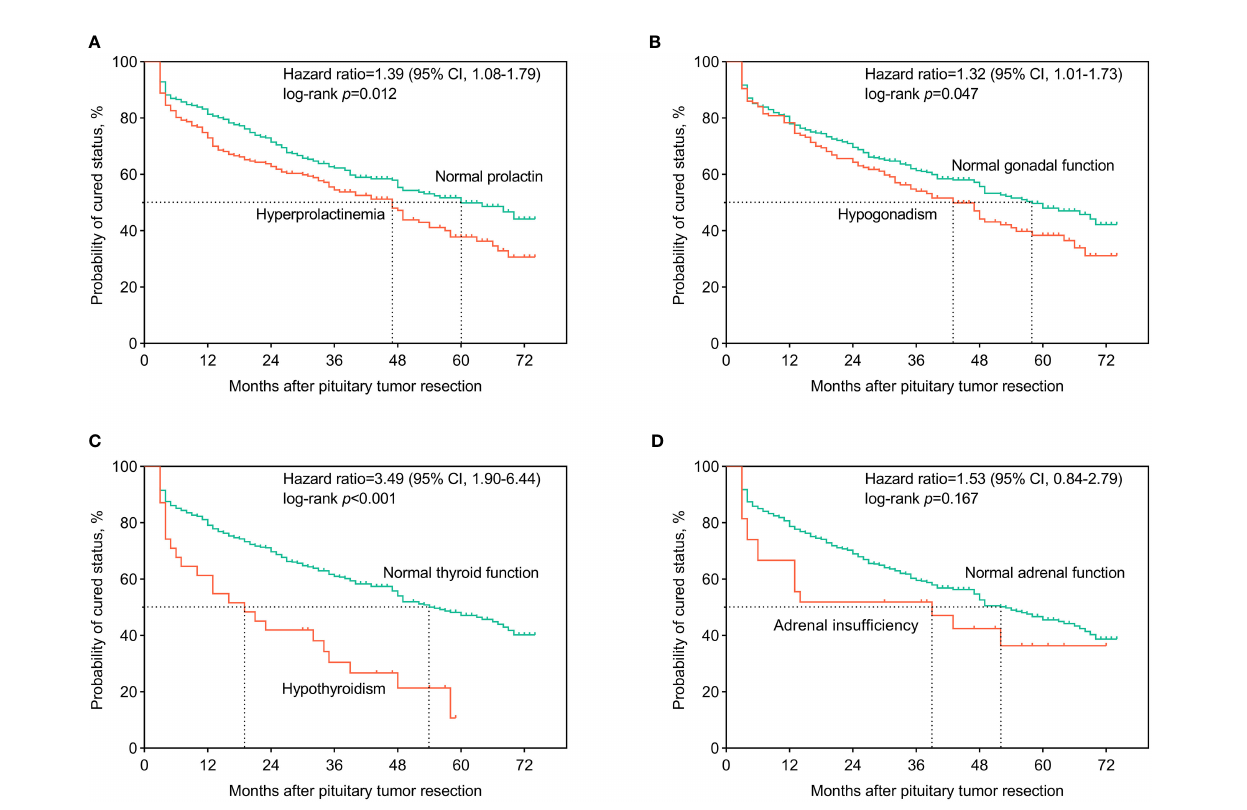
FIGURE 1 | Kaplan-Meier curves for surgical outcomes among acromegaly patients. The patients were classi fi ed according to whether or not having developed preoperative hyperprolactinemia (A) , central hypogonadism (B) , central hypothyroidism (C) , and central adrenal insuf fi ciency (D) . Hazard ratio and 95% credibility interval (95% CI) of hyperprolactinemia and axis-speci fi c hypopituitarism on the surgical outcomes, compared to normal hypothalamus-pituitary-end organ axes functions, were calculated and recorded on the panels. Log-rank tests were used to test the differences in the recurrence/cure rates after surgery between